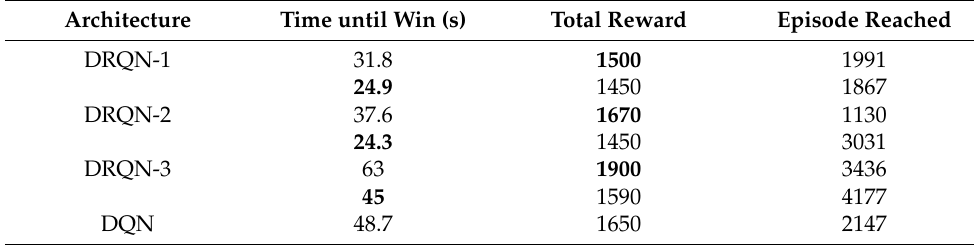
Table 4. Highest reward and fastest win for the most successful models.